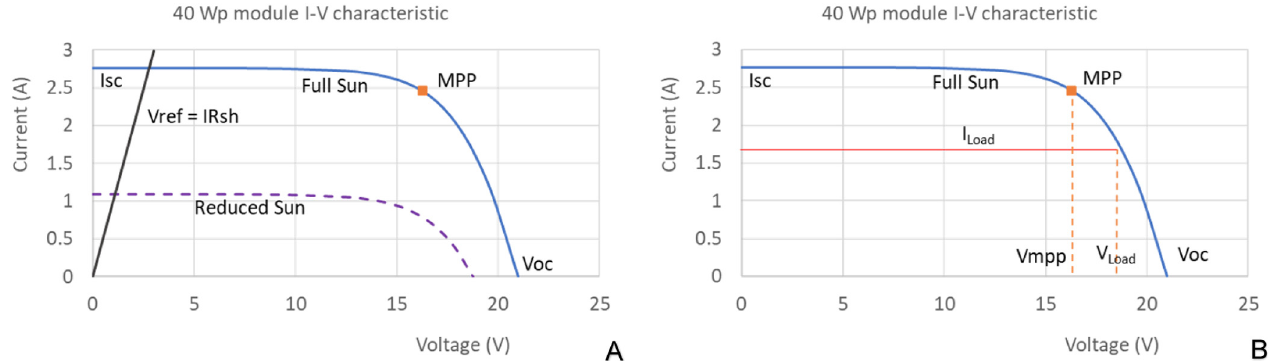
Fig. 9. Typical voltage and current curve for SHS module (A) with shunt resistance I – V characteristic; (B) showing how module voltage changes with